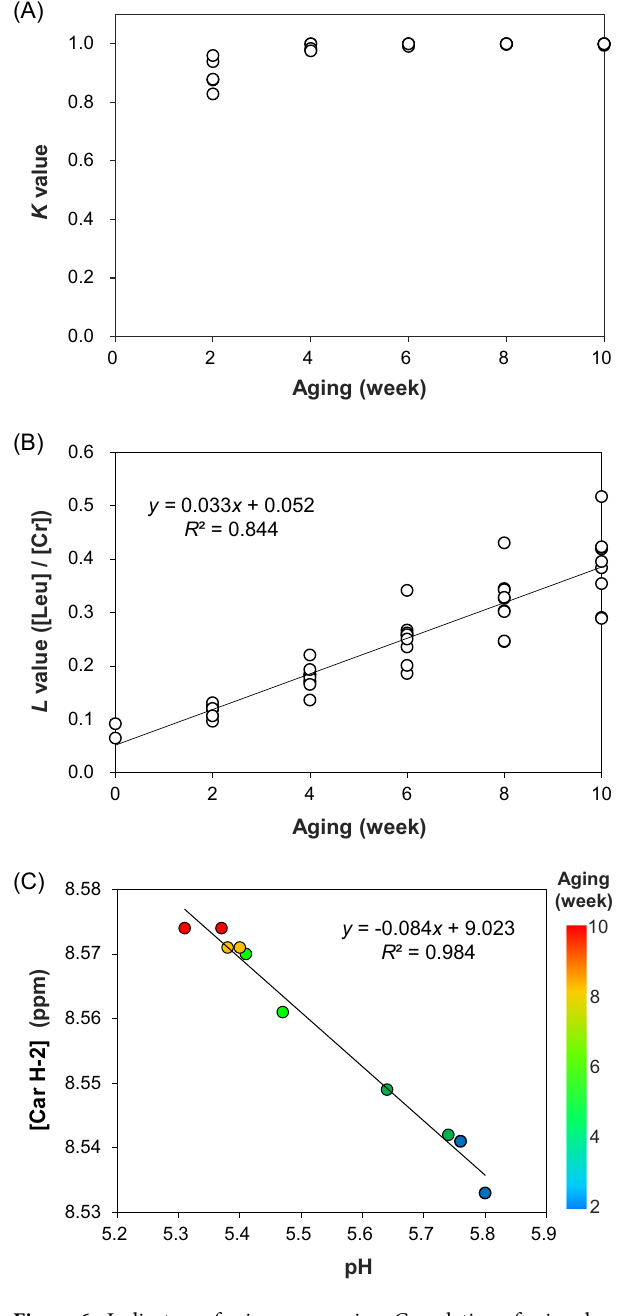
Figure 6. Indicators of aging progression. Correlation of aging duration with ( A ) K value and ( B ) L value, represented by the ratio of leucine ([Leu]) to creatine ([Cr]). ( C ) Correlation between pH and [Car H-2], represented by the chemical shift of the 1 H signal at C-2 of the imidazole ring of carnosine (Car). The [Car H-2] value in the observed pH range shows a linear correlation with pH, although overall pH profile of [Car H-2] is sigmoidal 42 . The plots are color-coded according to aging duration (week): 2, blue; 4, green; 6, light green; 8, yellow; and 10,